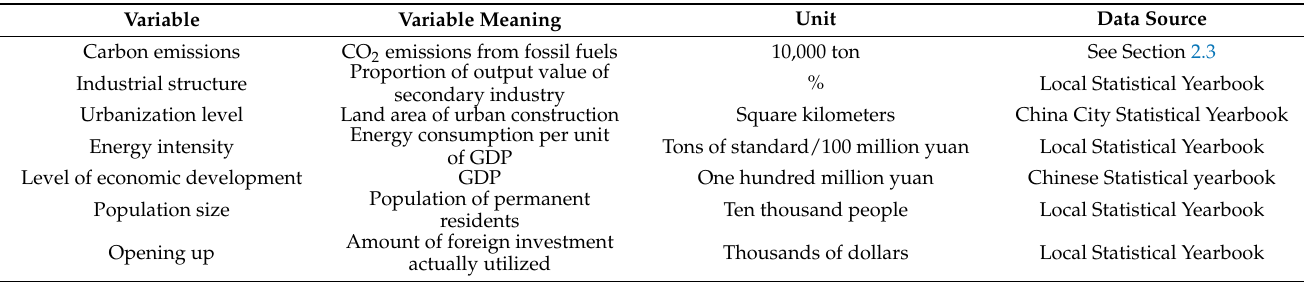
Table 1. Definition and sources of relevant